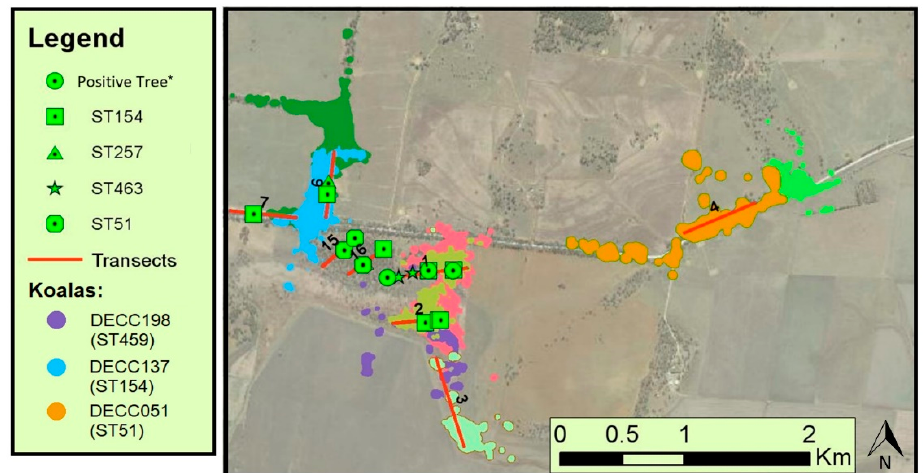
Figure 2. Map showing transects from the Watermark site overlaying koala home ranges with trees positive for C. gattii labelled, and associated sequence types provided when available. The regions highlighted in colours represent the home ranges of individual koalas. Only the koalas with nasal colonisation and sequence-typed isolates are denoted in the legend. * Positive trees from which isolates were collected but no sequence types were obtained due to sequencing issues.